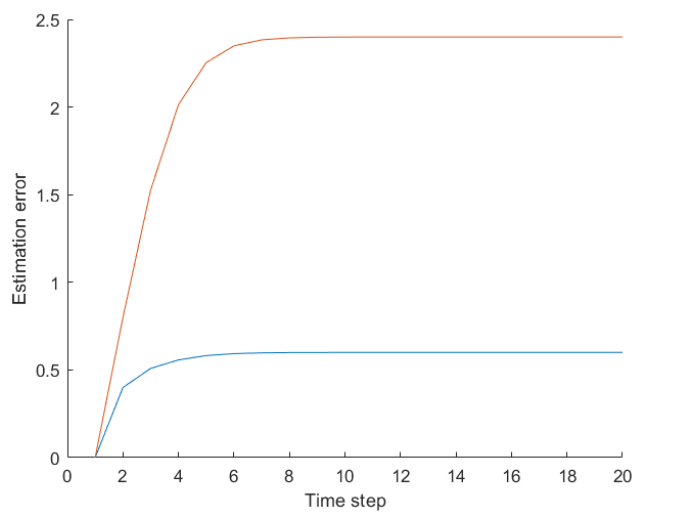
Figure 4. Convergence process of estimation error covariance P ( k ) .